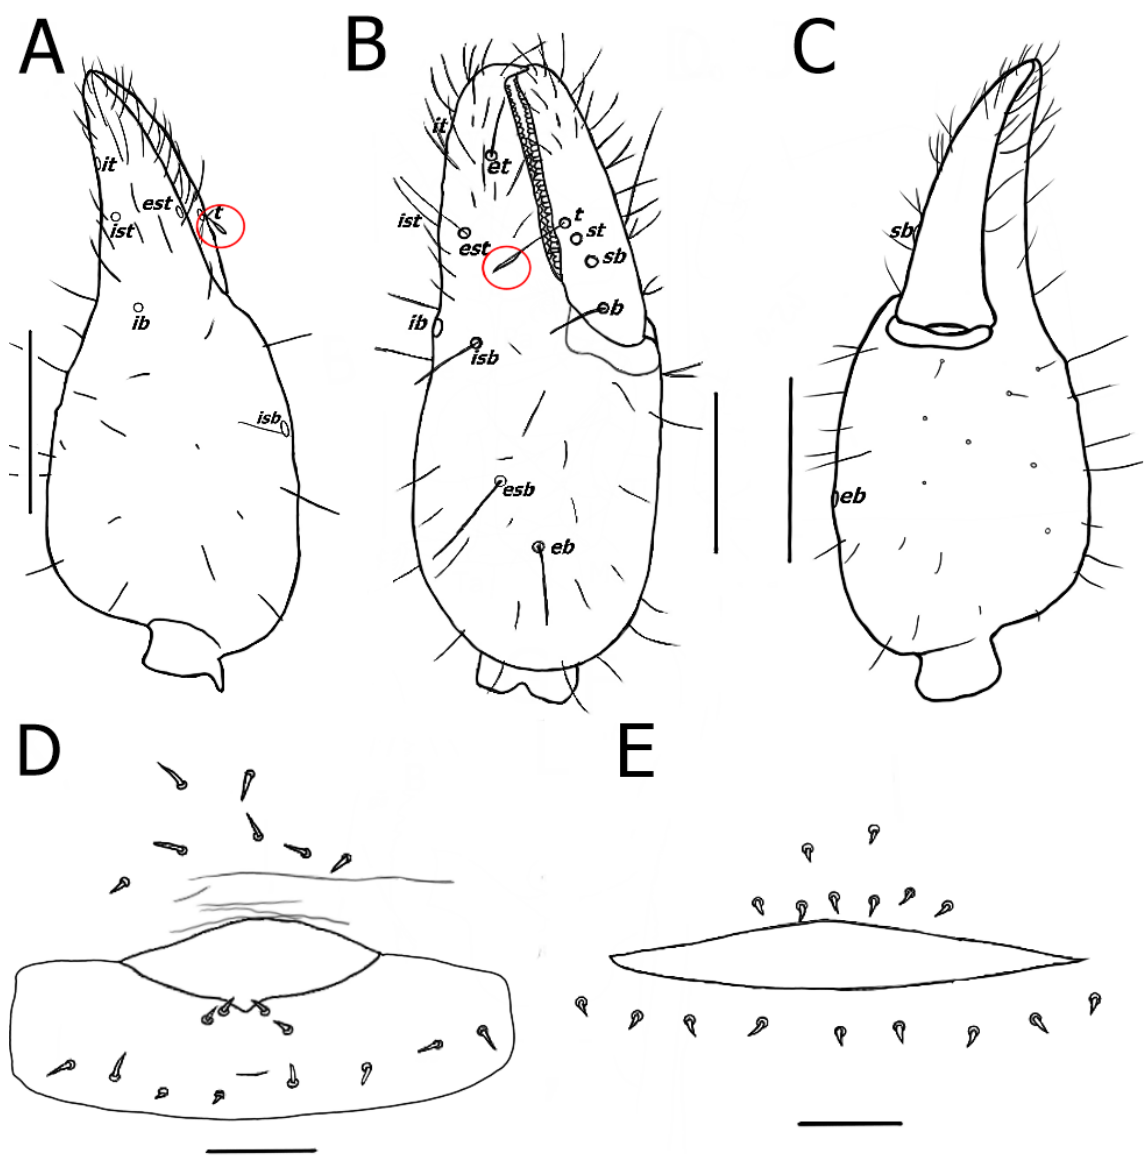
Fig. 8. Ideobisium kichwa sp. nov. A . Chela in dorsal view, showing trichobothria. B . Chela in retrolateral view, showing lanceolate trichobothrium t . C . Chela in ventral view. D . Outer genital area, showing setal arrangement. E . Genital area, showing setal arrangement. A–C, E: holotype, ♀ (QCAZ); D: allotype, ♂ (QCAZ). Scale bars: A–C = 25 µm; D–E = 50